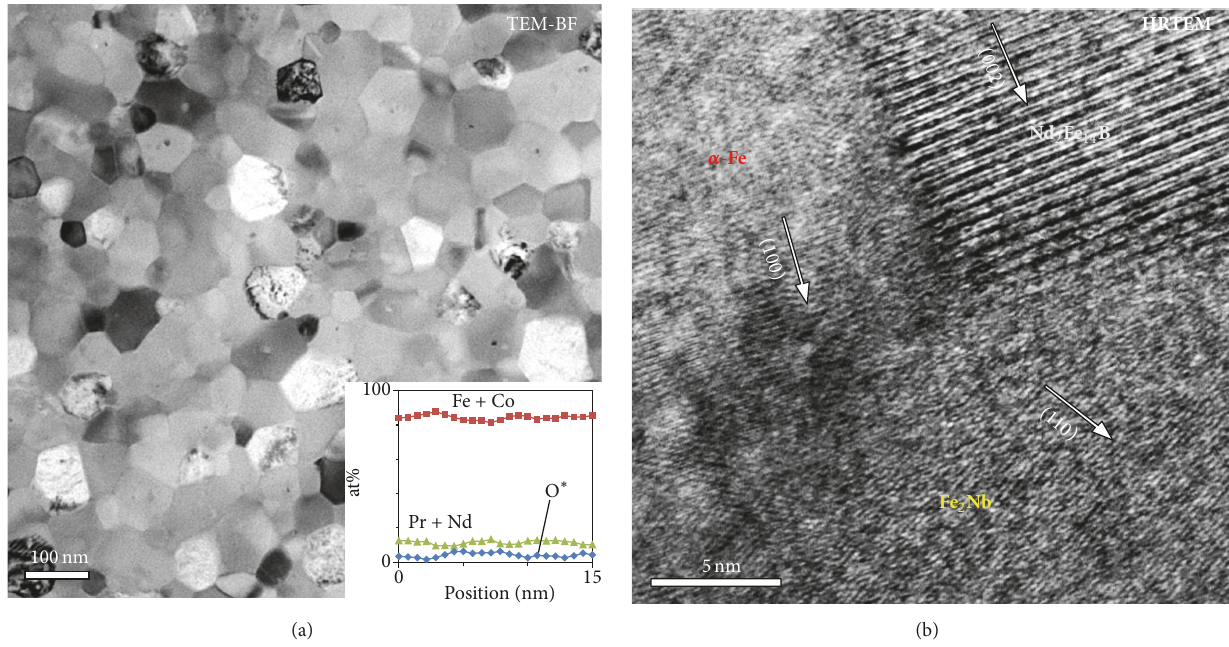
Figure 11: (a) TEM-BF image of the multiphase large grained nanocomposite. ((a) insert) No change in chemical composition in the EELS line scan across a GB. No separate GB-phase is detected. (b) HRTEM image of three granular phases.